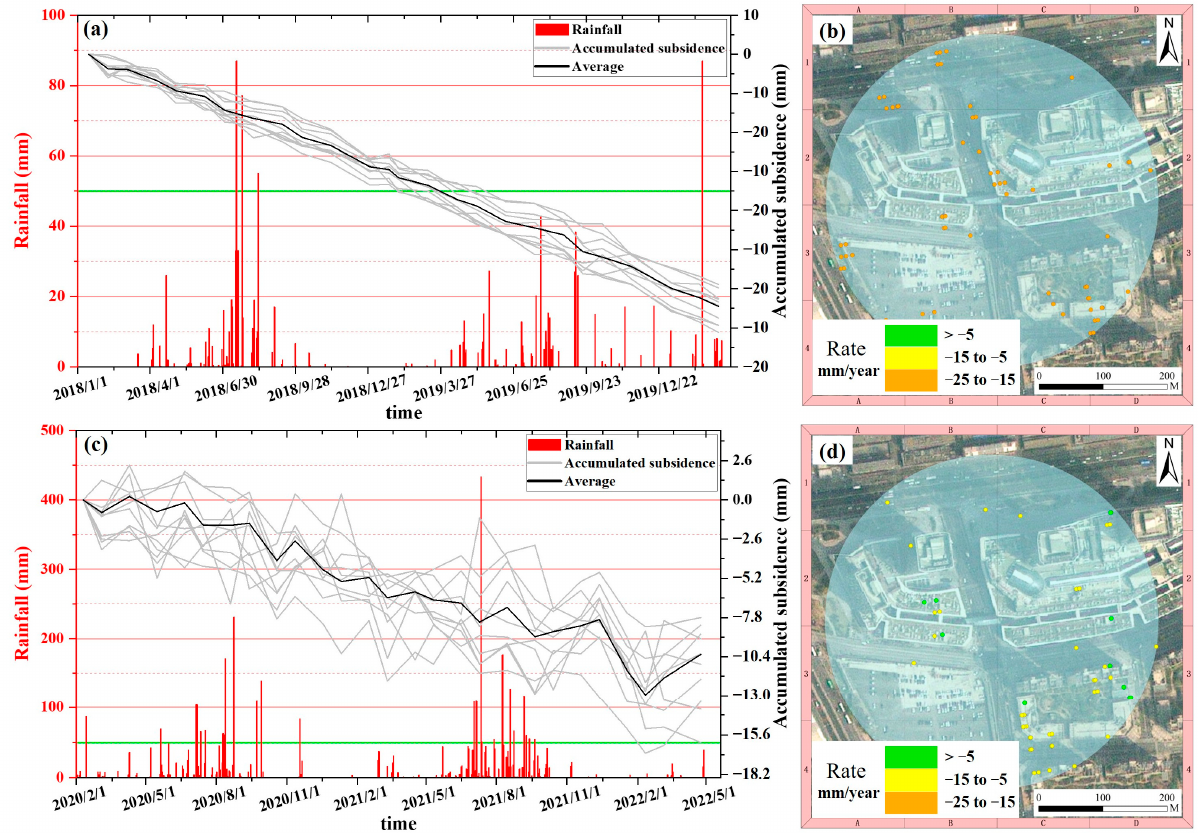
Figure 11. ( a ). Plot of cumulative surface deposition versus rainfall before the COVID-19 outbreak. ( b ). Selected reference points before the COVID-19 outbreak. ( c ). Plot of cumulative surface deposition versus rainfall after the COVID-19 outbreak. ( d ). Selected reference points after the COVID-19 outbreak. The red column is the rainfall data with a 1-day interval; the grey broken line is the sequential cumulative subsidence of the reference point with an interval of 1 month. The green horizontal line is the 50 mm line of rainfall.